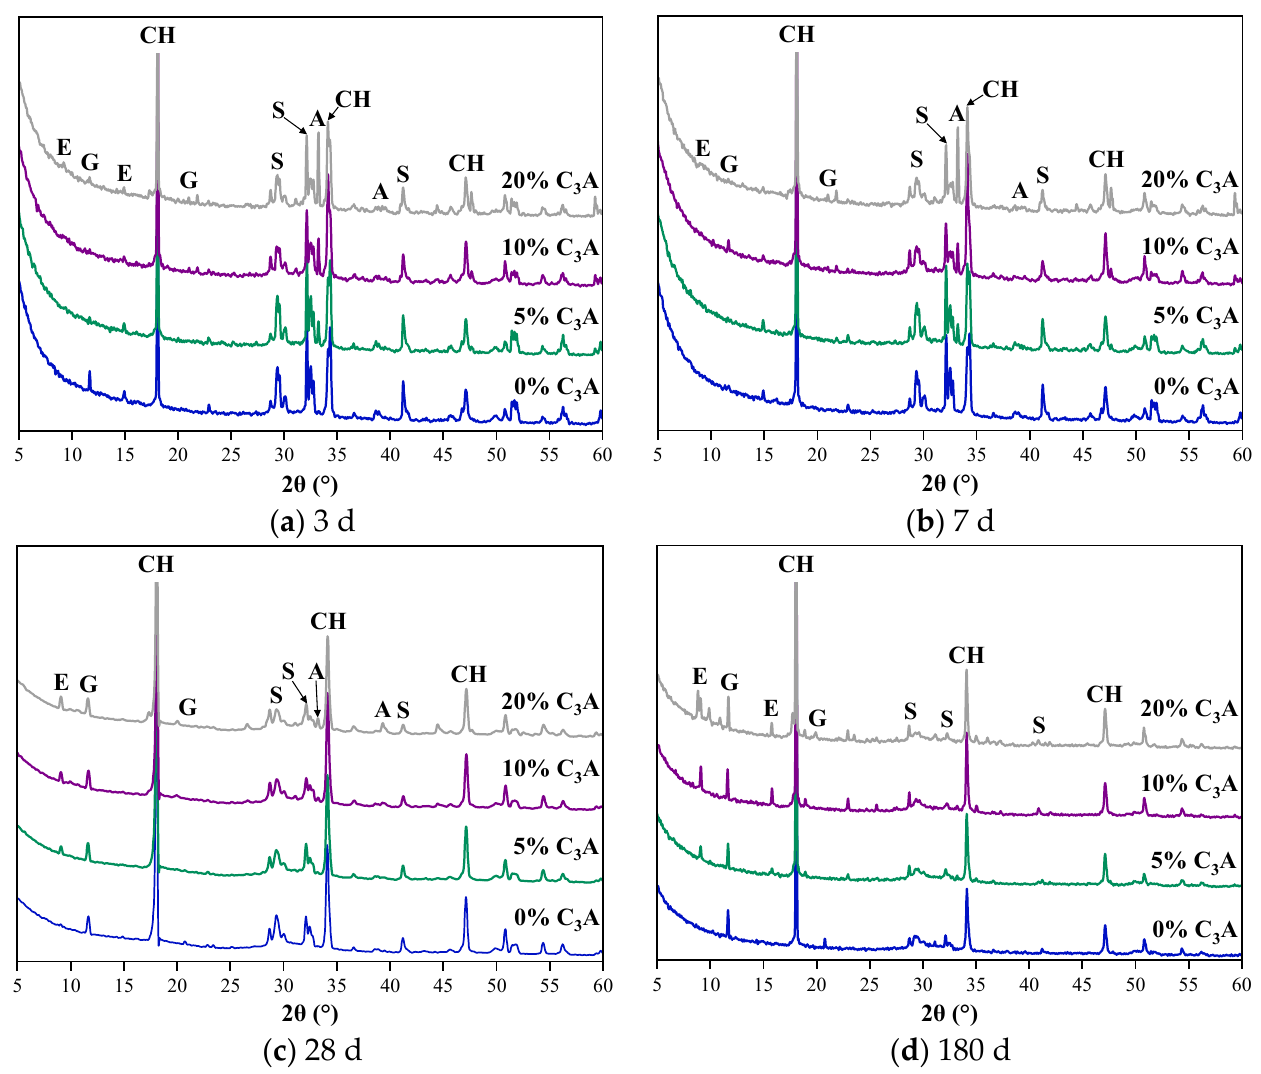
Figure 8. XRD NMR spectra of C 3 S-C 3 A paste under sulfate attack, where G = CaSO 4 ·2H 2 O, E = AFt, CH = Ca(OH) 2 , and S = C 3 S, A = C 3 A.